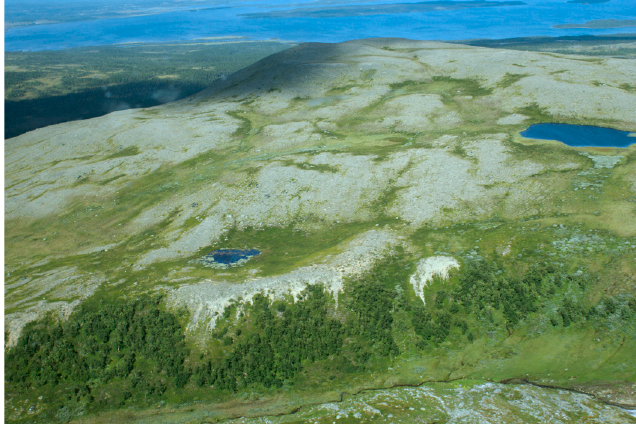
Figure 7: Over the past 100 years, the treeline has shifted 65 m upslope in this landscape. This implies that the upper half of the forest band did not exist in the early-20th centu- ry. Further treeline rise is virtually prohibited by the abrupt transition to wind-exposed and snow-poor terrain right at the current treeline position. Mt. Hårdeggen. 5 August.